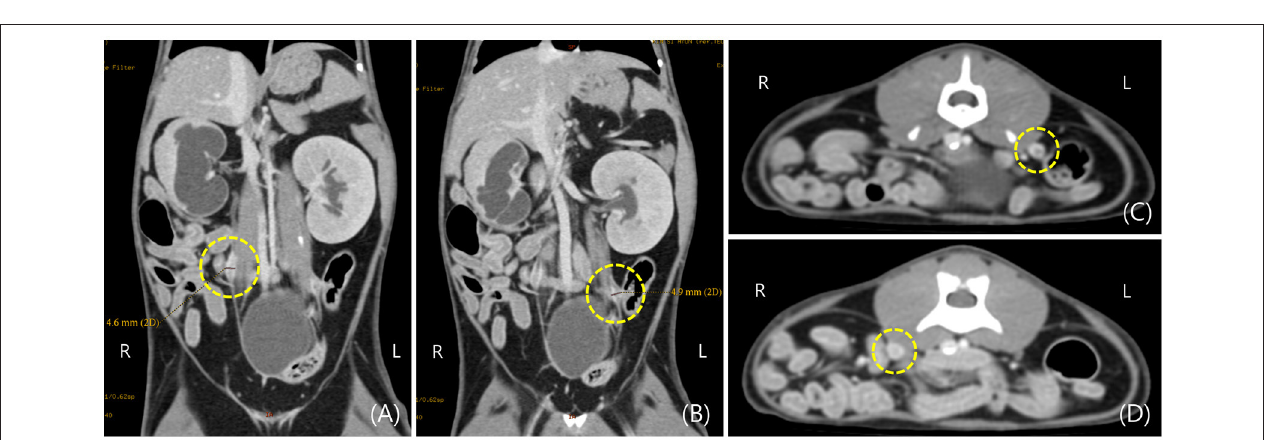
FIGURE 2 | Post-contrast computed tomography (CT) images of hydronephrosis in a cat with bilateral ureteral anomalies. (A,B) Focal thickening of the right and left ureteral wall was observed on the dorsal plane of CT image in the area indicated by the dotted circle. (C,D) Focal thickening of the right and left ureteral wall was observed on the transverse plane of the CT image in the area indicated by the dotted circle.